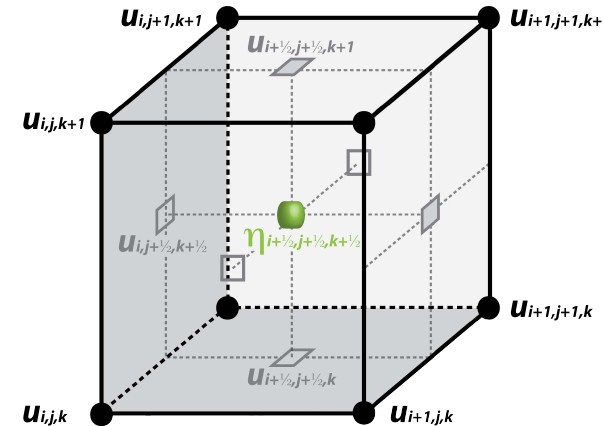
Fig. 1. Grid cell as used in the STAG implementation. Note that velocities are defined at grid points while effective viscosities are computed in the centre. To determine necessary velocity derivatives one first computes the velocity on each face of the grid